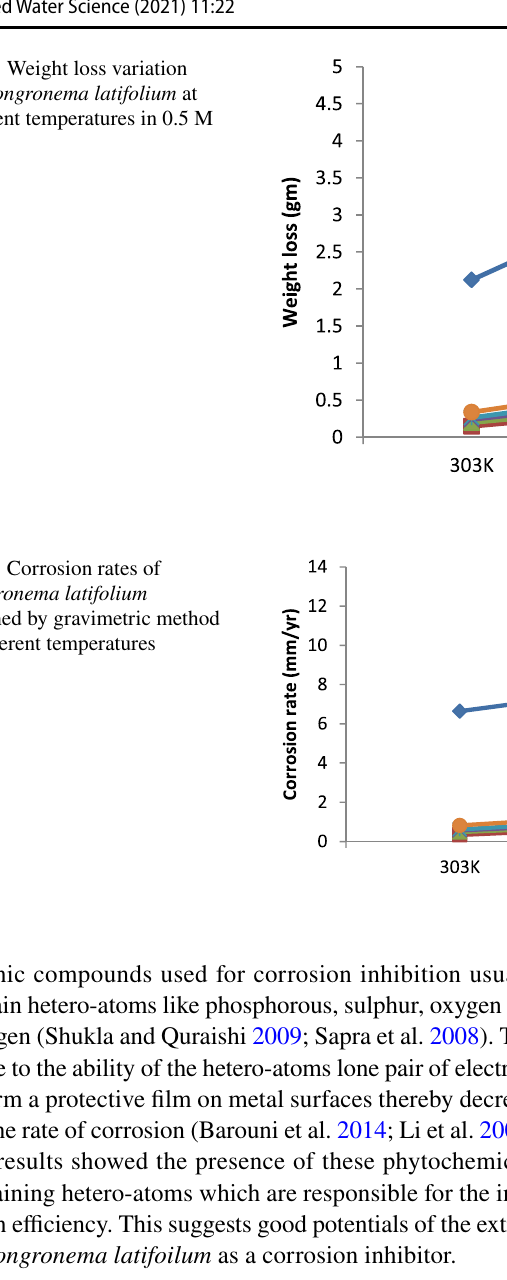
Fig. 1 Weight loss variation for Gongronema latifolium at different temperatures in 0.5 M HCl